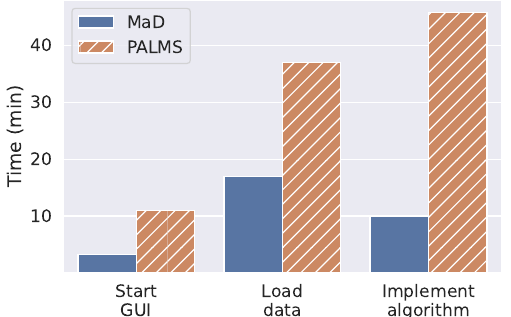
Figure 3. Median task completion time for developers. For the tasks Load data and Implement algorithm , the time needed for installing the required Python packages is not